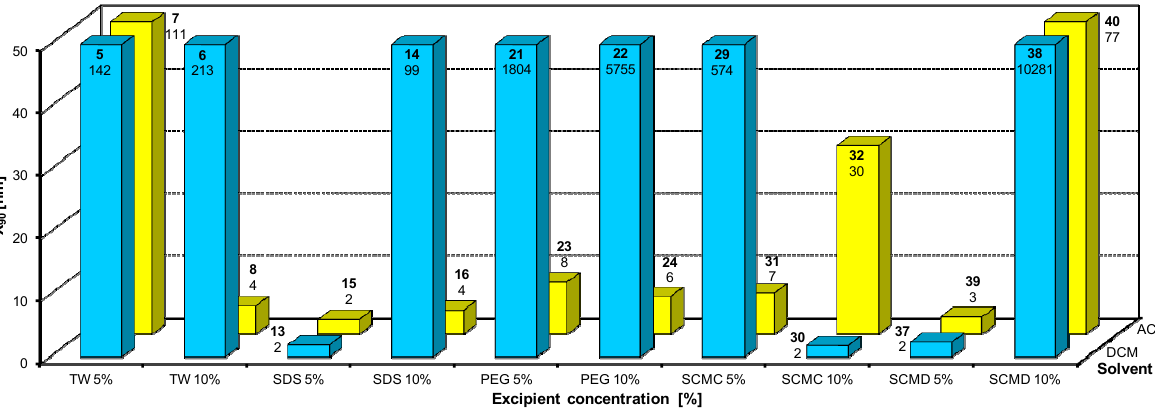
[nm]) of atorvastatin calcium ( II ) on Figure 8. Dependence of particle size (x 90 concentration [%] of Tween 80 (TW), sodium dodecyl sulfate (SDS), macrogol 6000 (PEG), sodium carboxymethyl cellulose (SCMC), sodium carboxymethyl dextran (SCMD) in dichloromethane (DCM) or acetone (AC). For clarity sake, the values on y-axis are only to 50 nm.